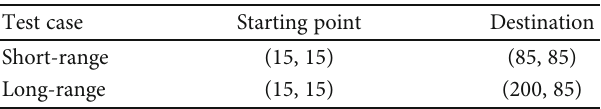
Table 2: The starting point and the destination for short-range and long-range test cases.